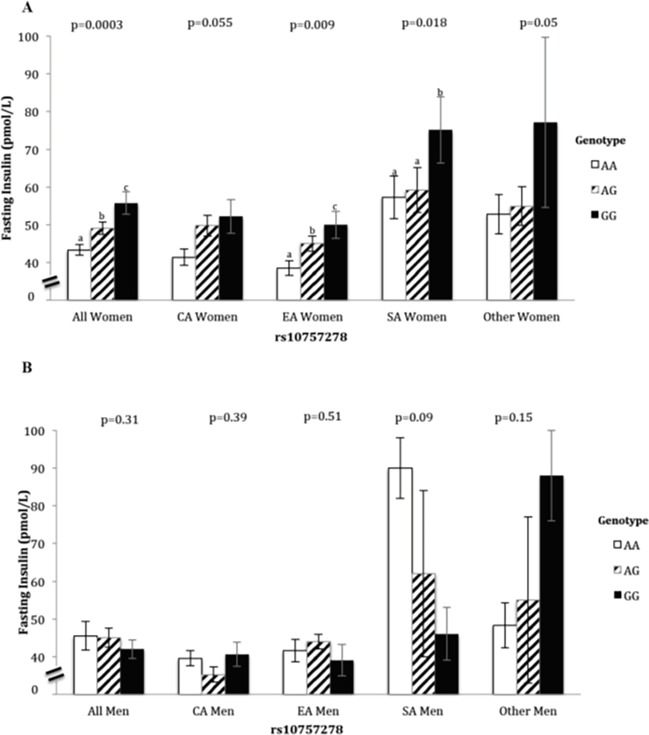
Fasting serum insulin by 9p21 genotype (rs10757278) in women (A) and men (B). ANCOVA was adjusted for: log-body mass index, diastolic blood pressure, log-waist circumference and plasma glucose. Fasting Insulin (pmol/L) was log-transformed, but expressed as normal mean to facilitate interpretation. Different letters, a, b and c indicate statistically significant differences in insulin concentrations between genotypes (pairwise differences) within a group which were tested only if overall ANCOVA for the group was statistically significant. p-value at the top of each group is indicative of overall differences in each group for comparing all three genotypes within the group. CA; Caucasians, EA; East Asians, SA; South Asians.